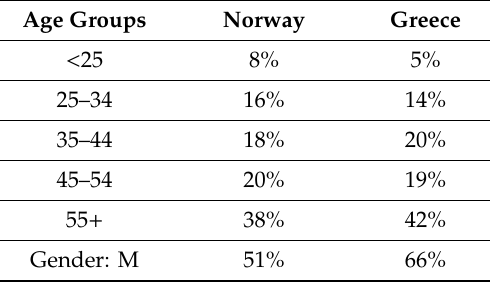
Table 3. Aggregated data on private car license holders in Norway and